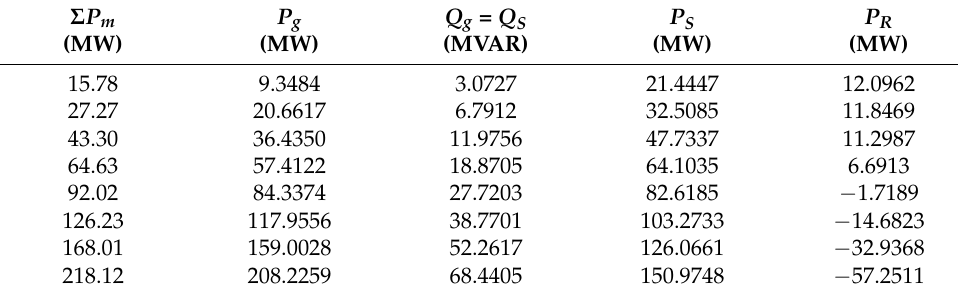
Table 10. DFIG power flow (PF = 0.95